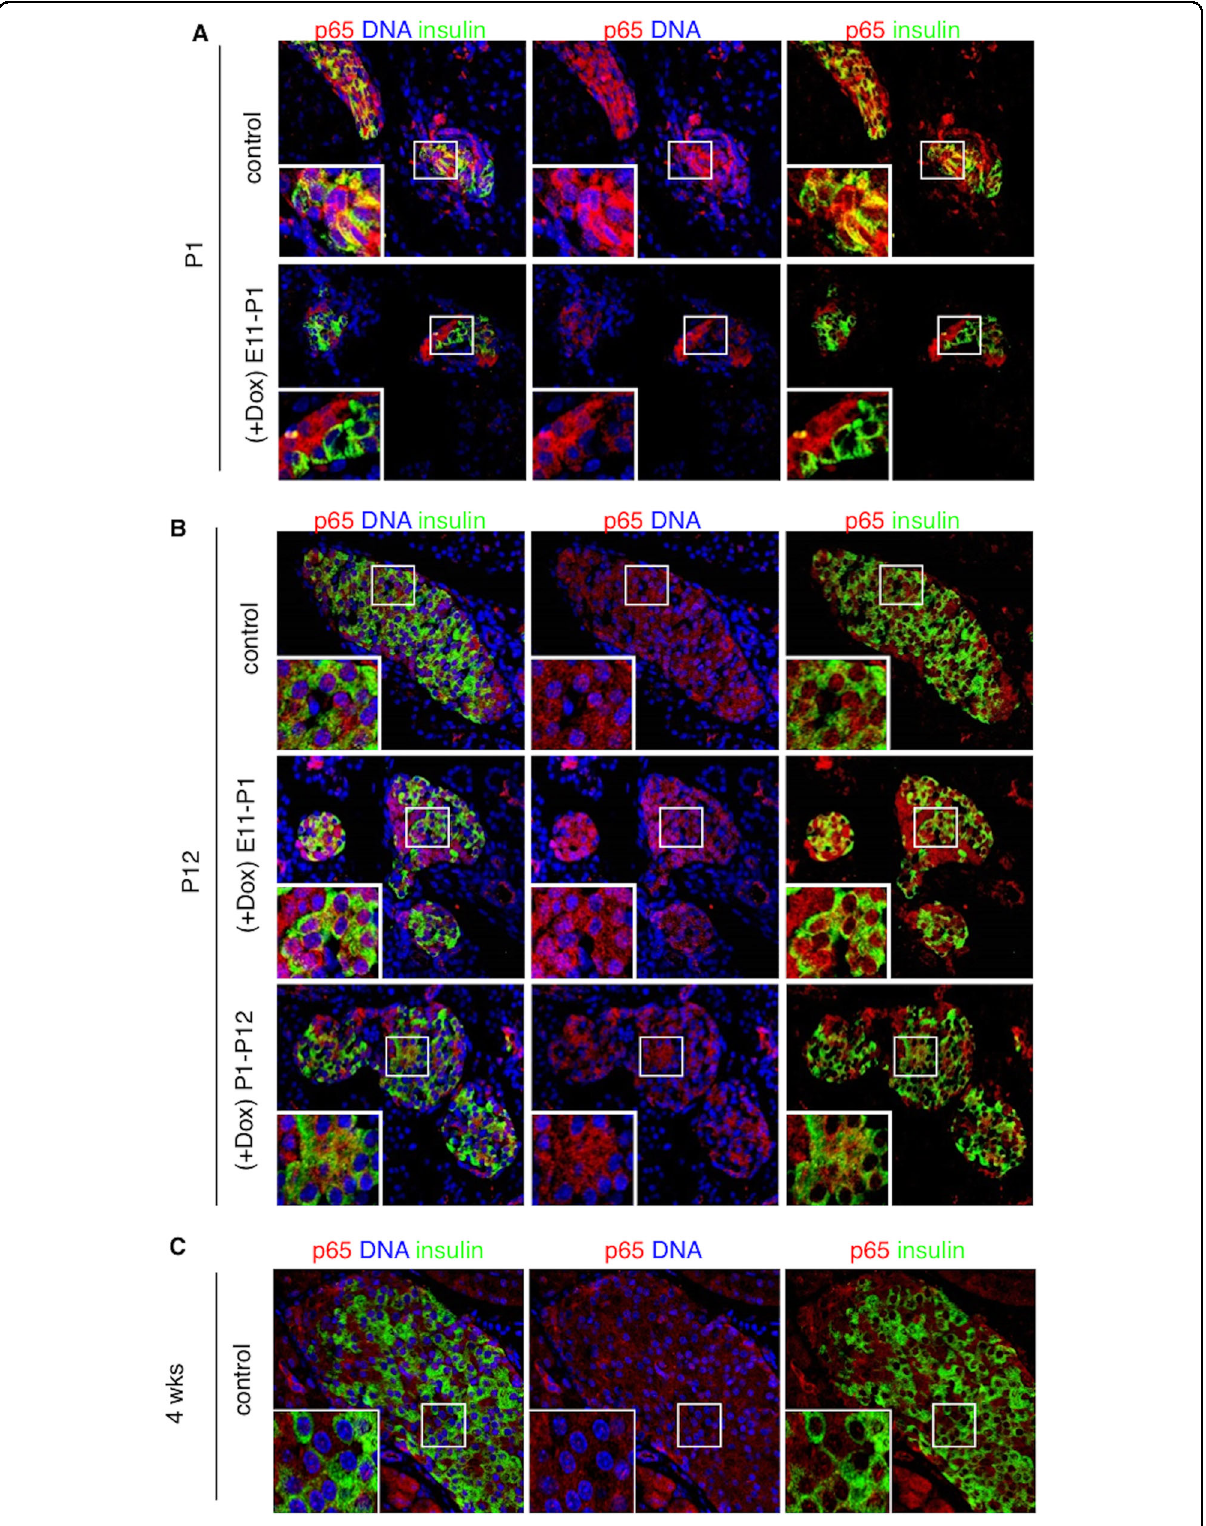
Fig. 1 Physiological localization of the NF- κ B p65-subunit in the pancreas of (A) newborn (P1), (B) neonate (P12), and (C) young adult (4 weeks) NOD/ToI β mice. Pancreata of untreated (control) or Dox-treated during the embryonic period (E11 – P1) or for 3 weeks after birth (P1 – P21) were immunostained for p65 (red), insulin (green), and DNA (blue). Pictures are representative confocal images of islets from three to fi ve different mice per group. For each mouse, ~15 islets were analyzed. Original images were taken at a magni fi cation of ×40. Inset images were digitally increased ×4. Of fi cial journal of the Cell Death Differentiation